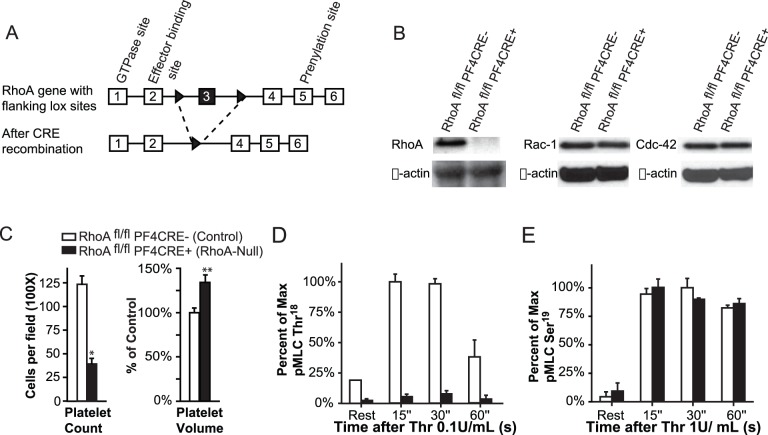
Mice with targeted deletion of RhoA in megakaryocytes and in platelets exhibit macrothrombocytopenia and impaired MLC phosphorylation.(A) The RhoA transgene construct contains loxP sites flanking exon three. These mice were crossed with mice expressing PF4 promoter-driven CRE recombinase. (B) Western blotting confirmed that platelets from RhoAfl/fl PF4CRE+ positive mice did not express detectable RhoA protein, but had normal amounts of Rac1 and CDC42. (C) Cell blood counts were normal, except that the RhoAfl/fl PF4CRE+ mice were macrothrombocytopenic. * indicates p<0.005, ** indicates p<0.05. The immunoblot of thrombin-treated platelets were probed with antibodies against the phospho-MLC2 Thr18 (D) or Ser19 (E). Phosphorylation of the MLC2 Ser19 residue was normal (D), but phosphorylation of the MLC2 Thr18 residue was undetectable in RhoA-null platelets for all stimulation times (E).